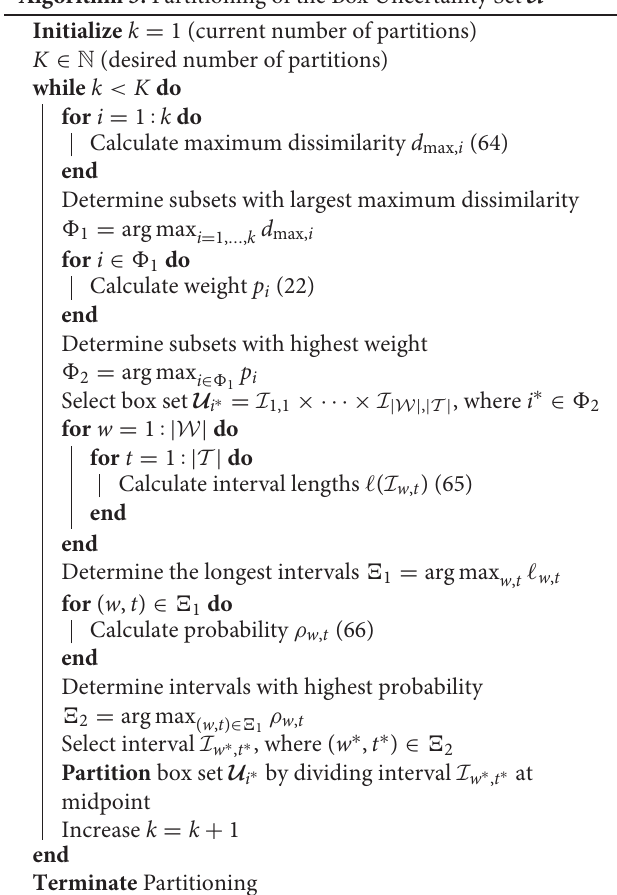
Algorithm 3: Partitioning of the Box Uncertainty Set U